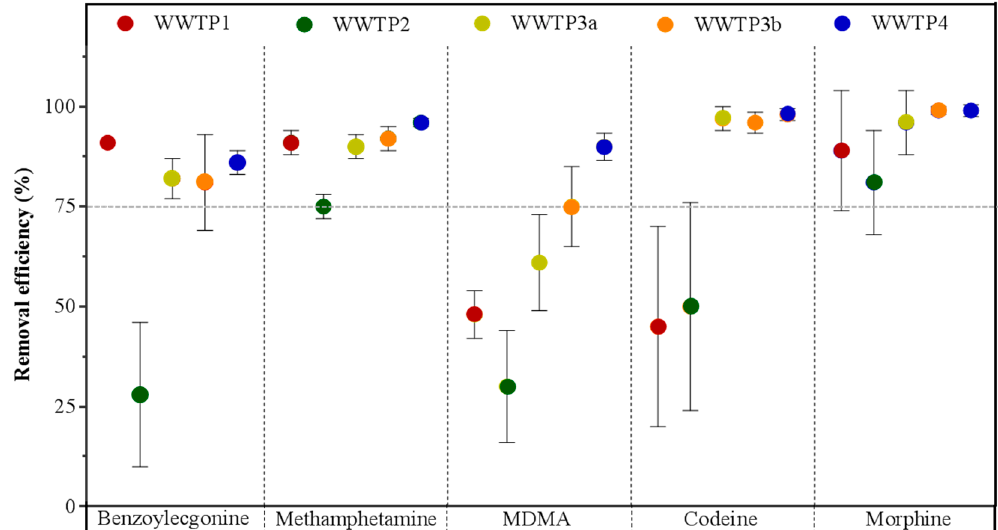
Figure 5. Removal efficiencies for the targeted drugs (mean ± SD) during the sampling duration at each of the four WWTPs.